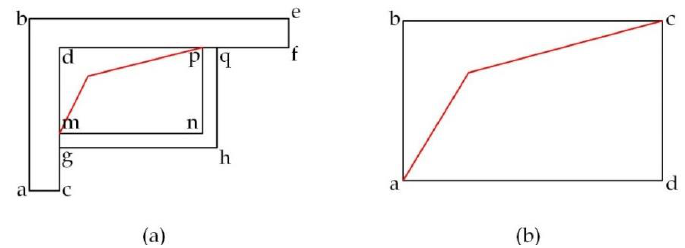
Figure 9. Cross-floor space representation in a construction plan: ( a ) pipe well and ( b ) atrium.